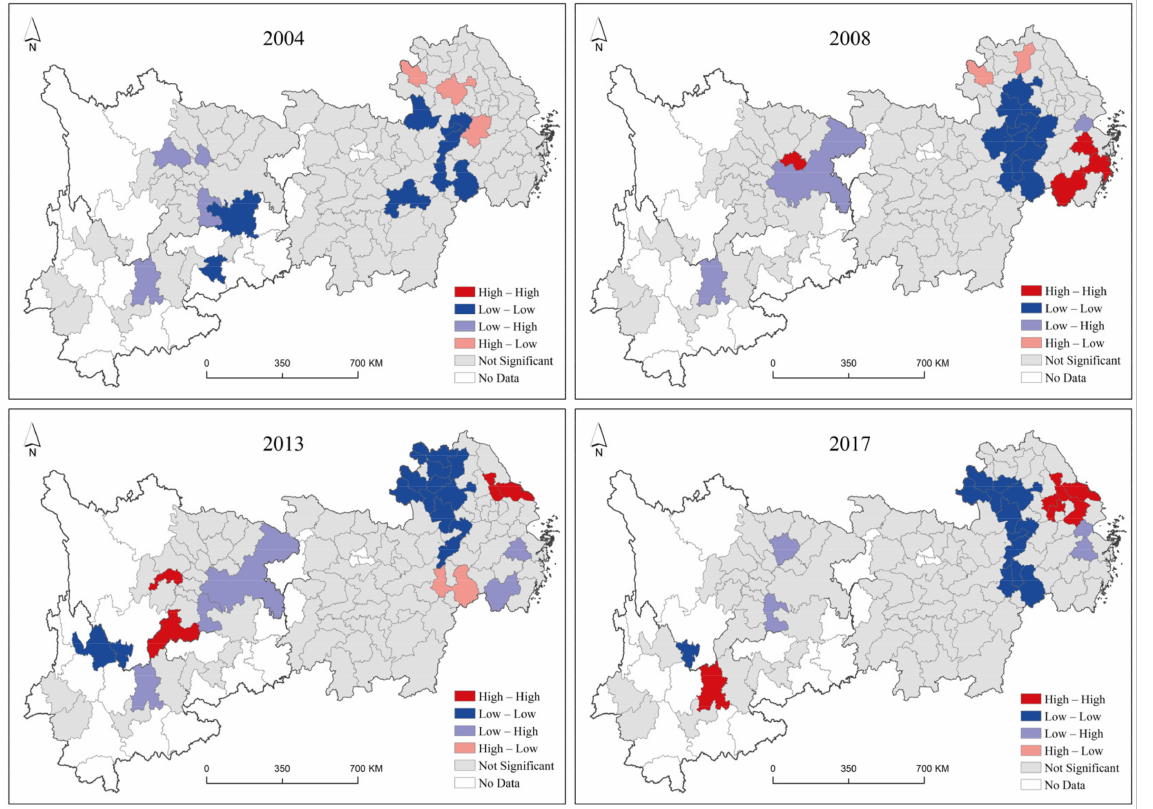
Figure 8. Local spatial autocorrelation clustering map of green development